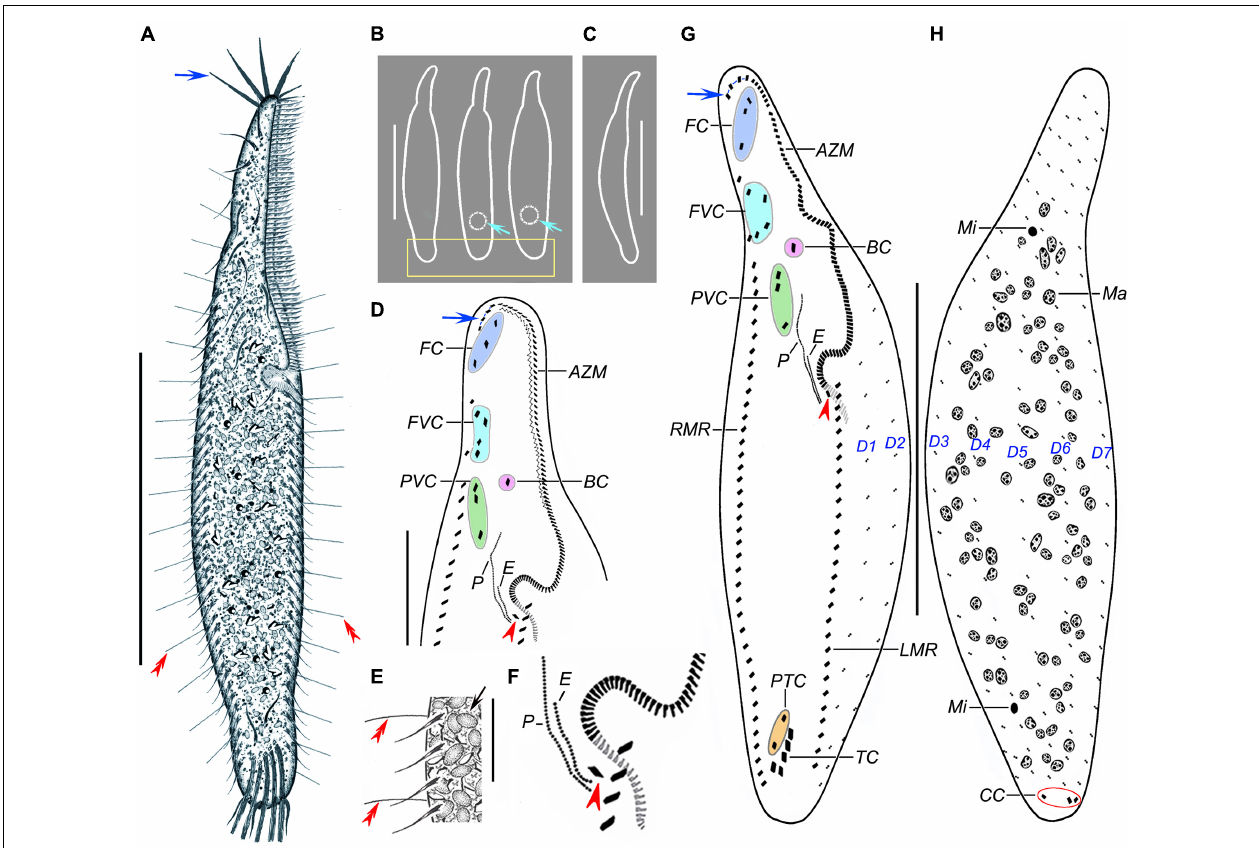
FIGURE 1 | Trachelostyla multinucleata spec. nov. from life (A–C,E) and after protargol impregnation (D,F,G,H) . (A) Ventral view of a representative individual; blue arrow shows the four enlarged adoral membranelles, and red double-arrowheads mark dorsal bristles. (B) Overviews, showing different body shapes; light-blue arrows mark the contractile vacuoles, and the rectangle delimits the posterior body end that is tail-like in freshly collected specimens or broadly rounded in cultivated specimens. (C) Lateral overview. (D) Detail of the oral region; blue arrow shows four enlarged adoral membranelles, and the red arrowhead marks the first left marginal cirrus which is distinctly displaced rightward, hence appearing as an extra cirrus. (E) Ventral view, showing endoplasmic granules (black arrow), right marginal cirri, and dorsal bristles (red double-arrowheads). (F) Detail showing an extra cirrus (red arrowhead) right of the left marginal cirral row. (G,H) Ventral (G) and dorsal (H) views of holotype specimen, showing the ciliary pattern and the nuclear apparatus. Blue arrow shows the four enlarged adoral membranelles, red arrowhead marks the extra cirrus, and red ellipse (in H ) delimits the three caudal cirri. AZM, adoral zone of membranelles; BC, buccal cirrus; CC, caudal cirri; E, endoral membrane; FC, frontal cirri; FVC, frontoventral cirri; LMR, left marginal cirral row; Ma, macronuclear nodules; Mi, micronuclei; P, paroral membrane; PTC, pretransverse ventral cirri; PVC, postoral ventral cirri; RMR, right marginal cirral row; TC, transverse cirri; D1–D7, dorsal kineties 1–7. Scale bars = 20 µ m (E) , 50 µ m (D) , and 130 µ m (A–C,G,H)